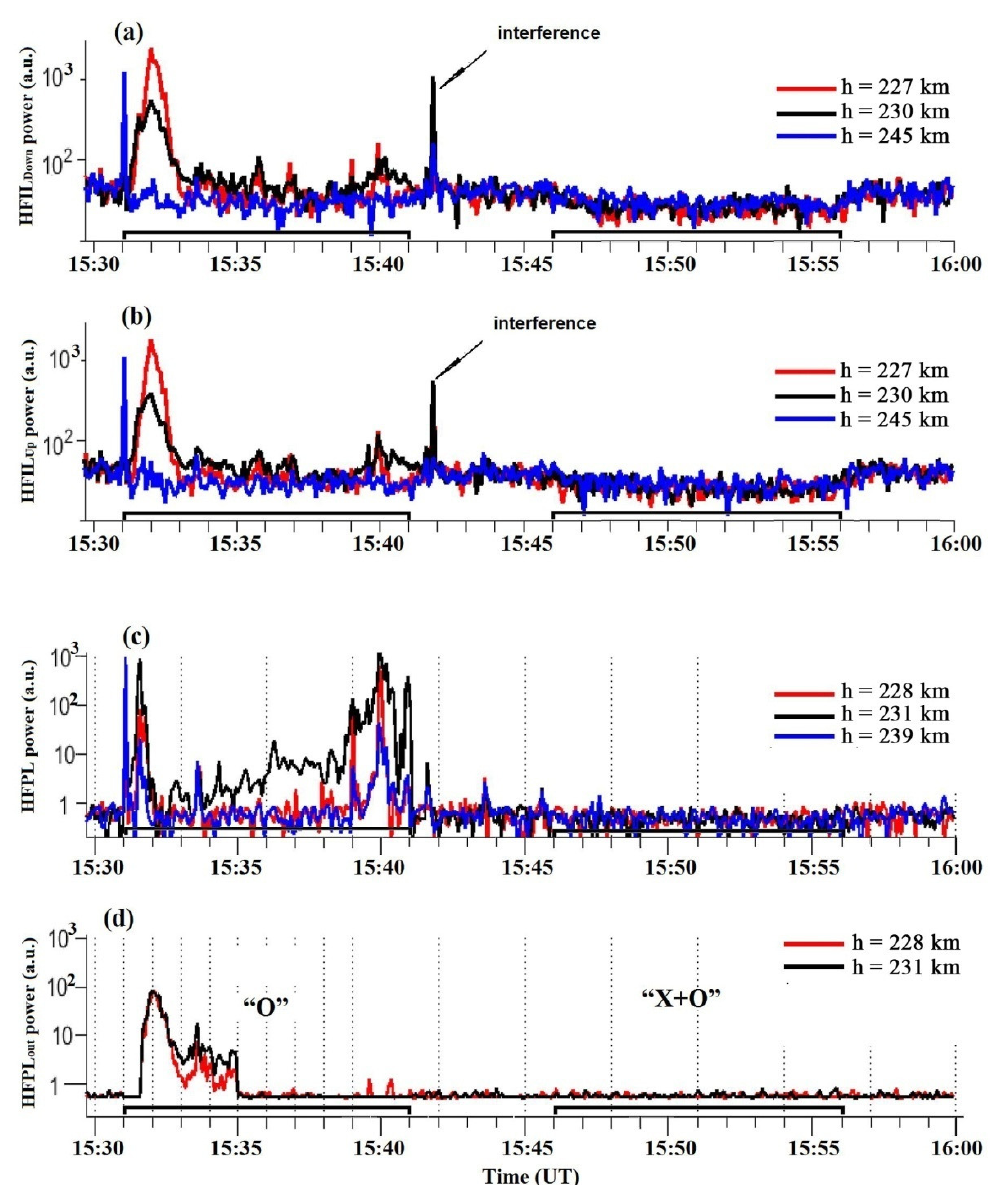
Figure 9. Temporal behavior of ( a ) the HF-induced downshifted ion lines, ( b ) upshifted ion lines, ( c ) downshifted plasma lines, and ( d ) outshifted plasma lines at fixed heights in the course of the experiment on 28 October 2015 from 15:30 to 16 UT. Data were obtained with a 5 s integration time. The pump pulses and polarization of the pump wave are shown on the time axis.